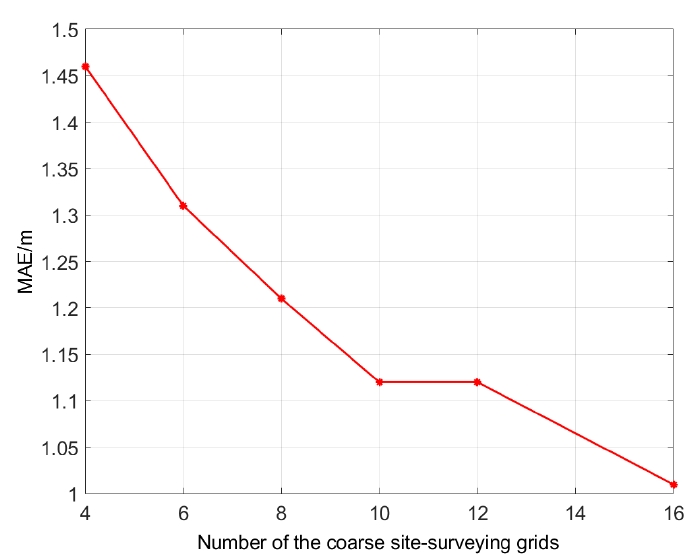
Figure 11. Mean absolute error (MAE) of SS-RSS Versus the number of the coarse site-surveying grids.